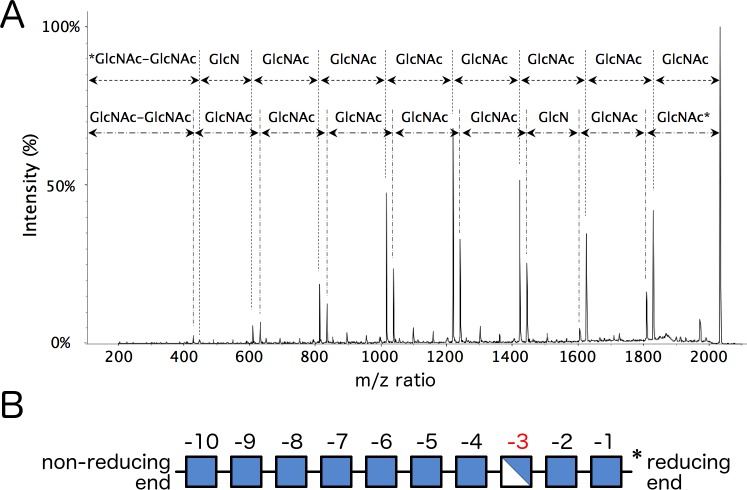
Structural analysis of Bb-DAGH treated PNAG reveals a consensus recognition motif.(A) MALDI-TOF MS/MS profile of the m/z ion = 2031.71, a mono-deacetylated PNAG 10-mer. Oligosaccharides were reduced by NaBH4 allowing the reducing terminus to be defined. The asterisk indicates the reducing end of the molecule. (B) Graphical representation of the dPNAG 10-mer using the same key as depicted in Fig 1B. Sugar units are numbered relative to the cleavage site at the reducing end.